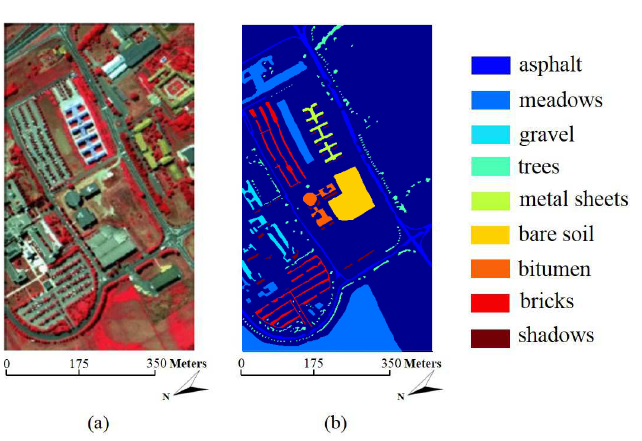
Figure 6. University of Pavia data. ( a ) Three band false color composite and ( b ) ground truth data with 9